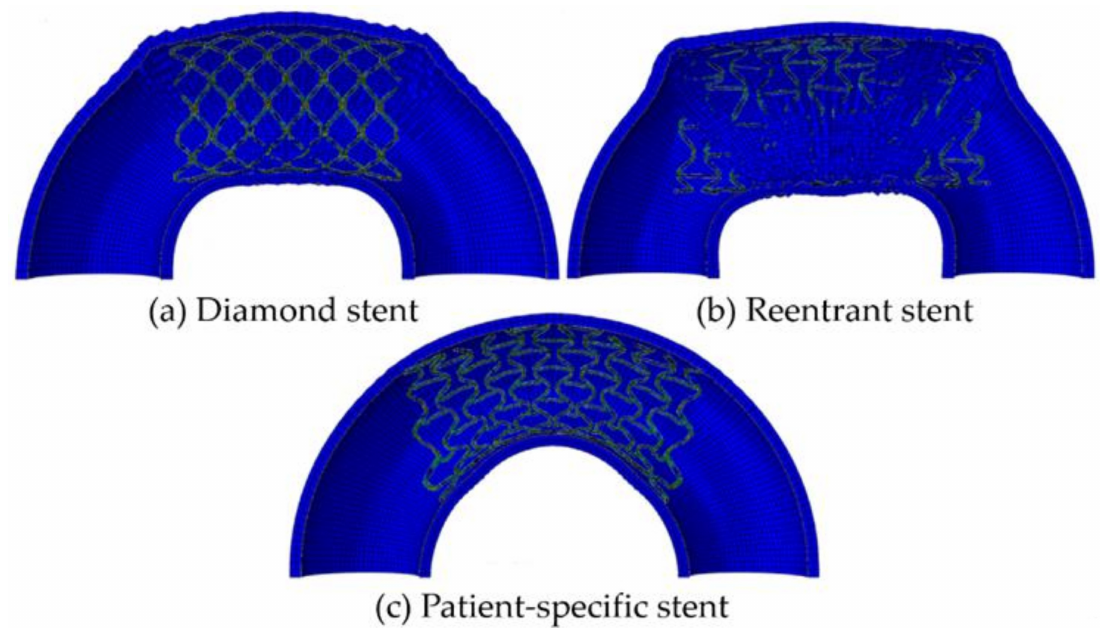
Figure 19. FEA results of four different stent-vessel systems after expansion [124]: ( a ) Diamond stent; ( b ) Reentrant stent; ( c ) Patient-specific stent.